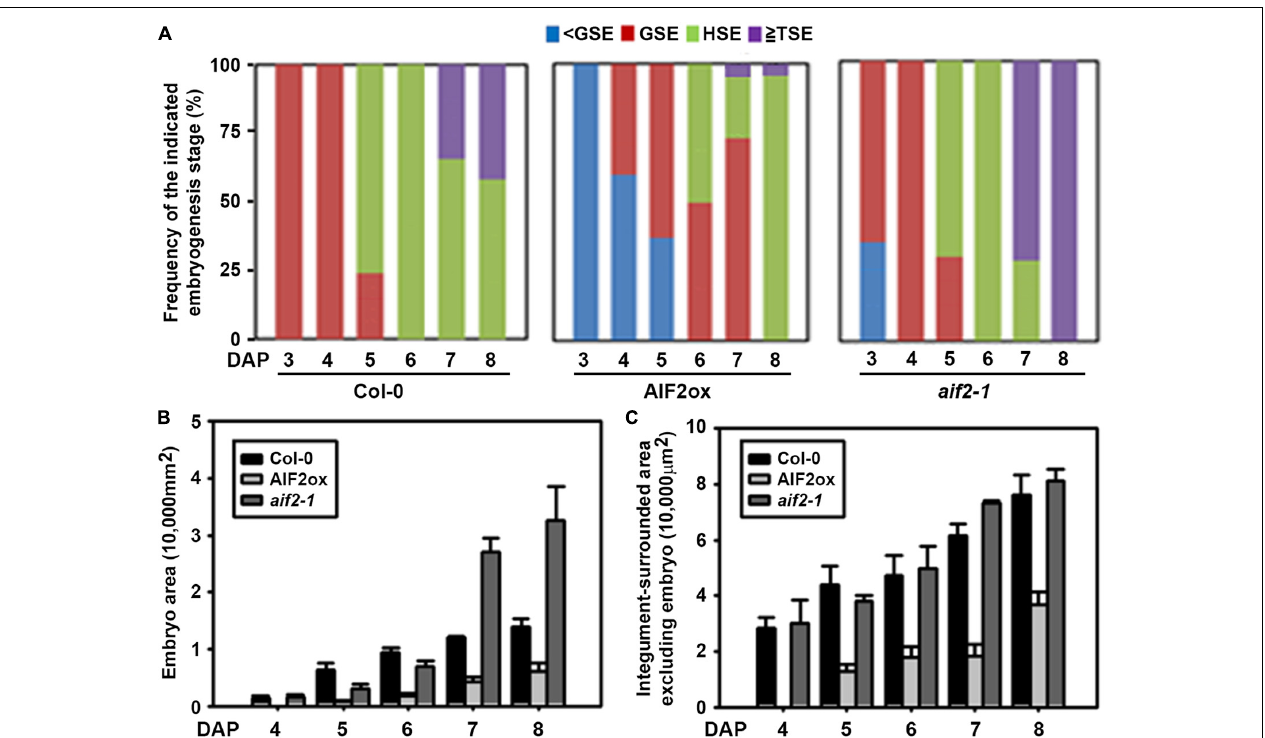
FIGURE 5 | Delayed embryogenesis and smaller embryo development in AIF2 -overexpressing p35S:AIF2-EGFP (AIF2ox) transgenic plants. (A–C) Comparison of the frequency of developmental stages of embryos (A) , size of embryo area (B) , and the size of remaining integument-surrounded area excluding the embryo (C) observed at different days after hand-pollinated self-pollination (DAP). < GSE, pre-globular stage; GSE, globular stage embryo; HSE, heart stage embryo; TSE, torpedo stage embryo. Number of embryos examined for each time point > 150–200.